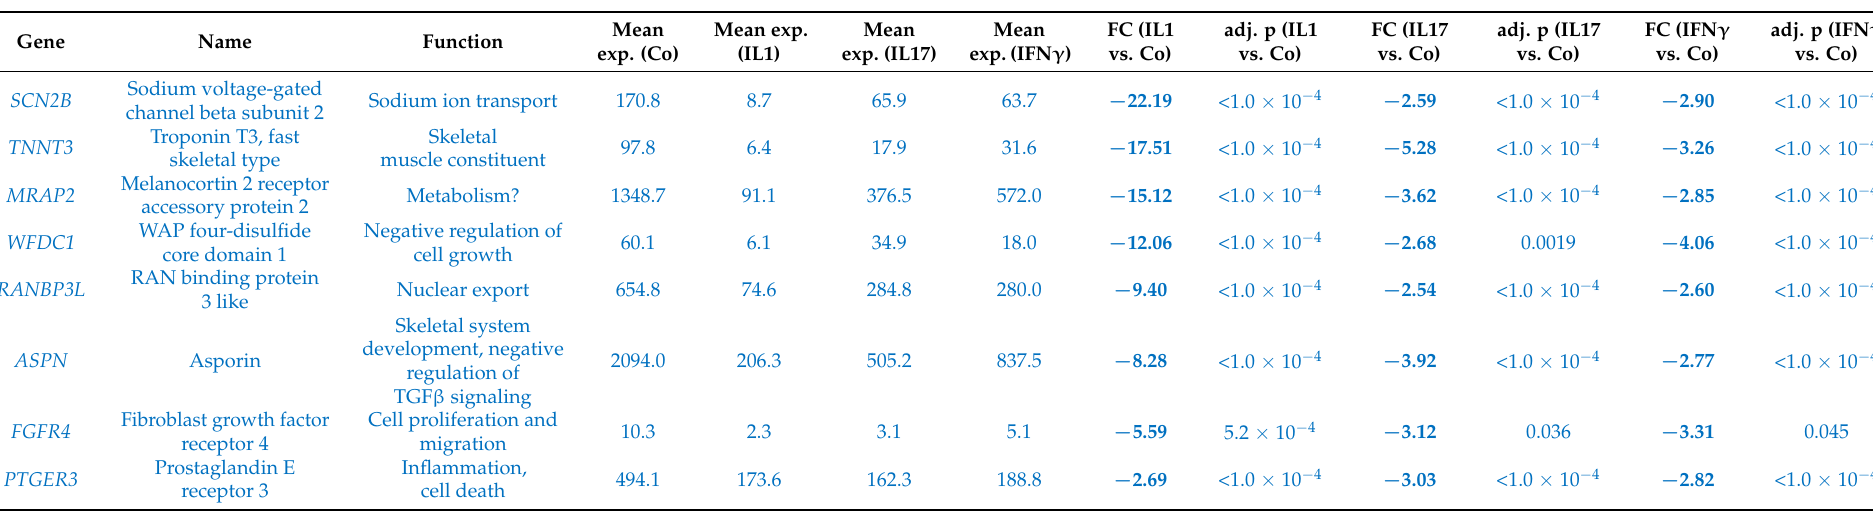
Table 6. Genes downregulated by all studied proinflammatory cytokines with FC < − 2.5. Shown are mean normalized expression levels in control (Co), in C(IL1), C(IL17) and C(IFN γ ) phenotypes, fold changes (FCs) for all comparisons vs. control and false discovery rate (FDR)-adjusted p values for